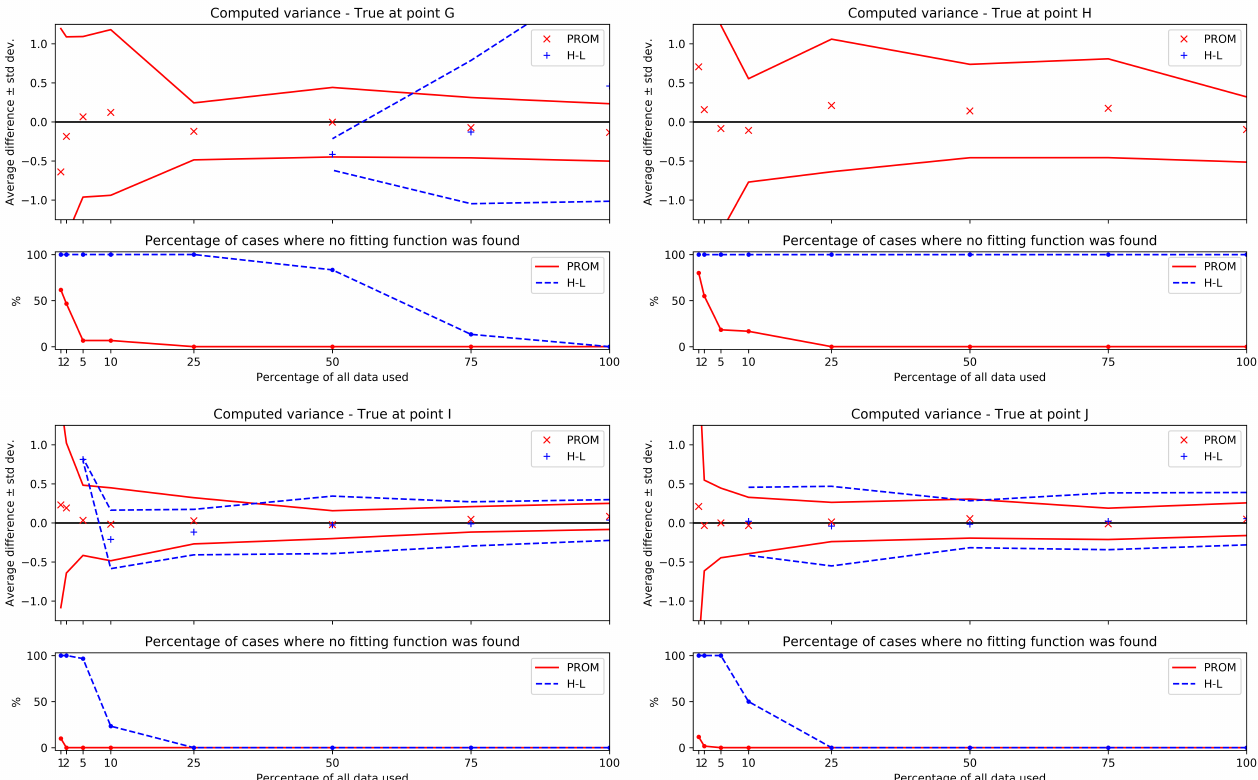
Figure 7. Comparison of variance values obtained by H-L and PROM methods. Each plot represents results obtained from at least 30 numerical experiments realised at each point (see Figure 2 on page 9). The top part of each plot shows comparisons of differences of the computed variance with respect to the true value of 1 (red × for PROM method, blue + for H-L). The lines represent the standard deviation of computed values for all realisations of the same experiment with different random innovations. The bottom part of each plot shows the percentage of cases where each method failed to produce a value of the